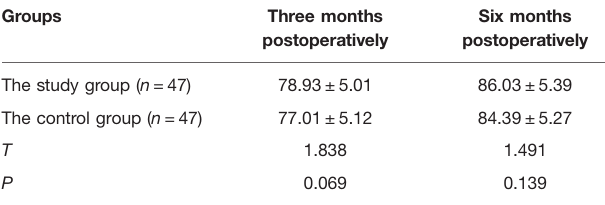
TABLE 5 | Comparison of Harris scores between the two groups ( (cid:1) x +